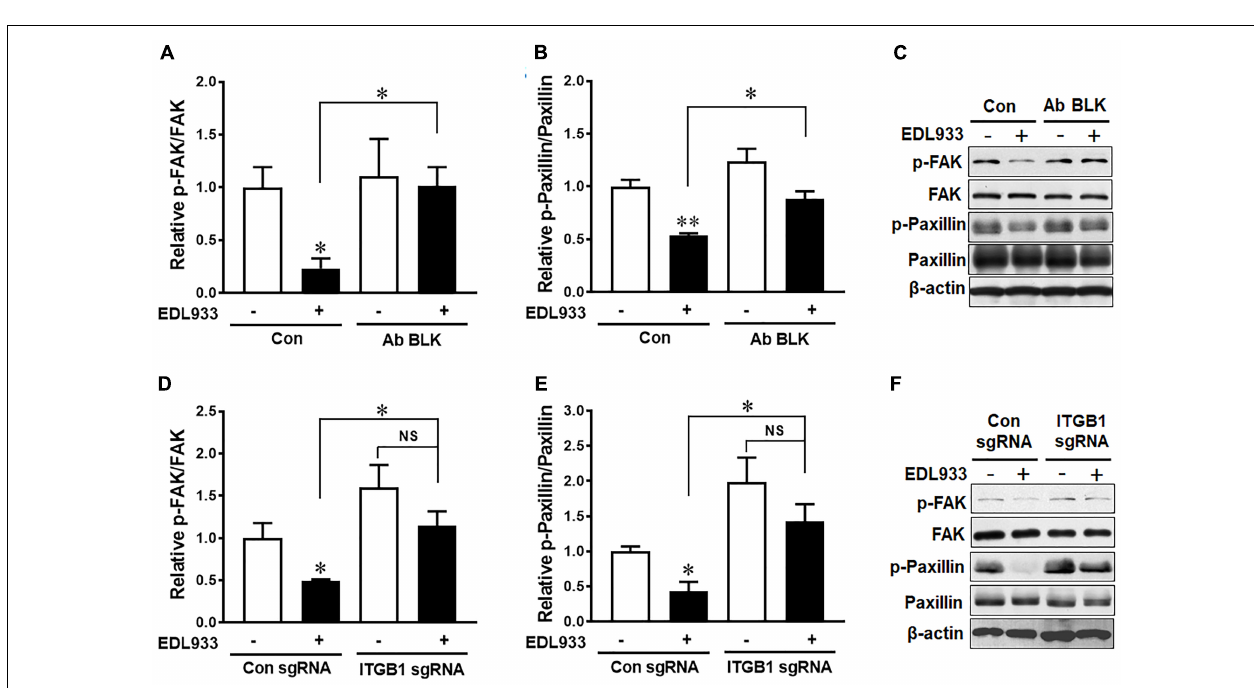
FIGURE 2 | Escherichia coli O157:H7 inhibited FAK activation through interaction with integrin β 1. (A–C) Immunoblotting analysis of FAK and paxillin in Caco-2 cells with or without integrin β 1 antibody blocking (Ab BLK). (D–F) Phosphorylation of FAK and paxillin in Caco-2 cells transfected with scramble control (Con sgRNA) or integrin β 1 knockout (ITGB1 sgRNA) plasmid followed with infection of EDL933 strain for 4 h. Means ± SEM; n = 4. ∗∗ P ≤ 0.01; ∗ P ≤ 0.05; NS, not significant at P ≤ 0.05.